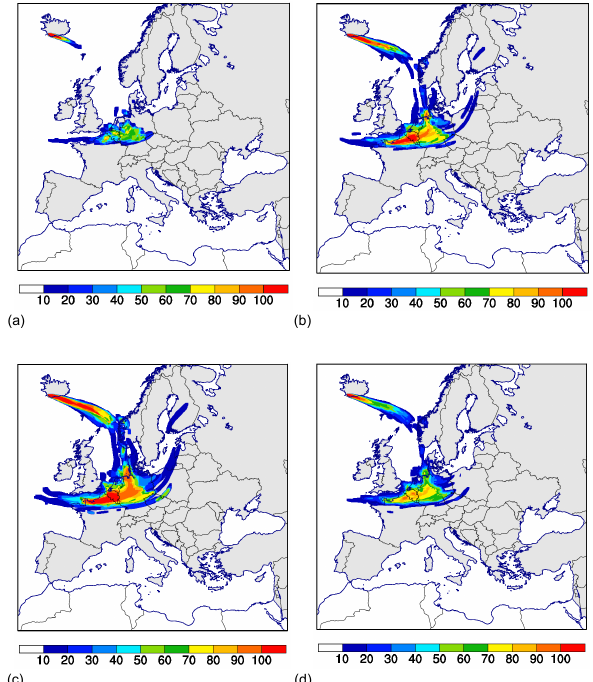
Figure 9. Probability to exceed a threshold concentration of vol- Figure 9: Probability to exceed a threshold concentration of volcanic ash of 2000 µg m -3 in % 641 between flight levels FL200 and FL350 (6096 m and 10668 m) at 16 April, 12:00 UTC. a: 642 canic ash of 2000µgm − 3 in % between flight levels FL200 and model runs with reduced plume height; b: reference runs; c: model runs with increased 643 FL350 (6096m and 10668m) at 16 April, 12:00UTC. (a) model plume height; d: all model runs. 644 runs with reduced plume height; (b) reference runs; (c) model runs 645 with increased plume height; (d) all model